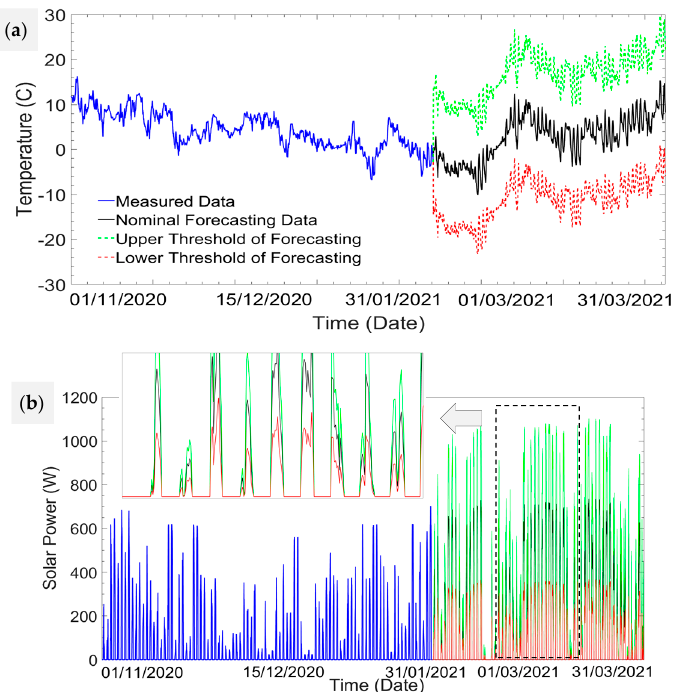
Figure 3. Weather data with uncertain envelopes for 3 months training and 2 months forecasting ( a ) Ambient temperature ( b ) Solar power.